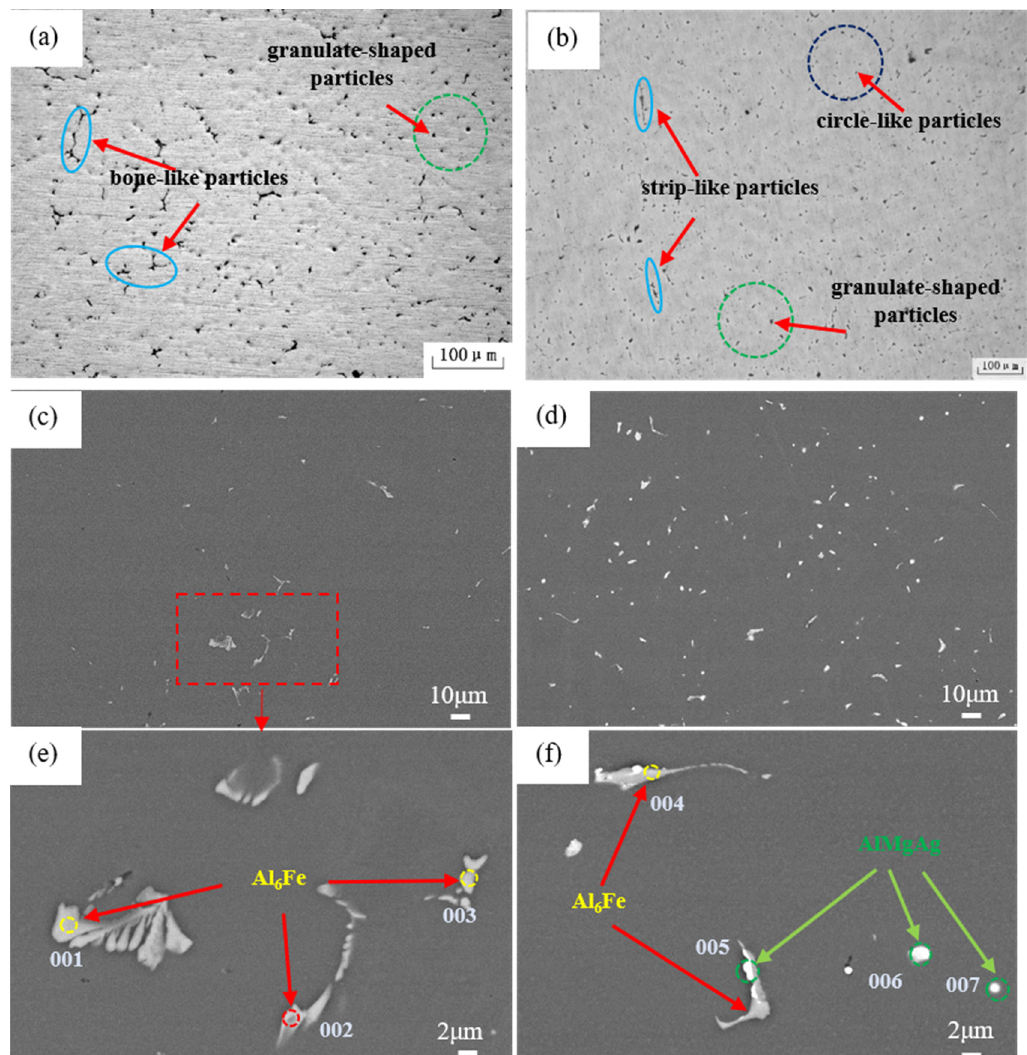
Figure 1. OM images of ( a ) as-cast Al-4Mg alloy, ( b ) as-cast Al-4Mg-0.6Ag alloy; ( c , e ) SEM pictures of Al-4Mg alloy, ( d , f ) SEM images of Al-4Mg-0.6Ag alloy. Table 1. Composition of test points as marked in Figure 1 (wt.%).